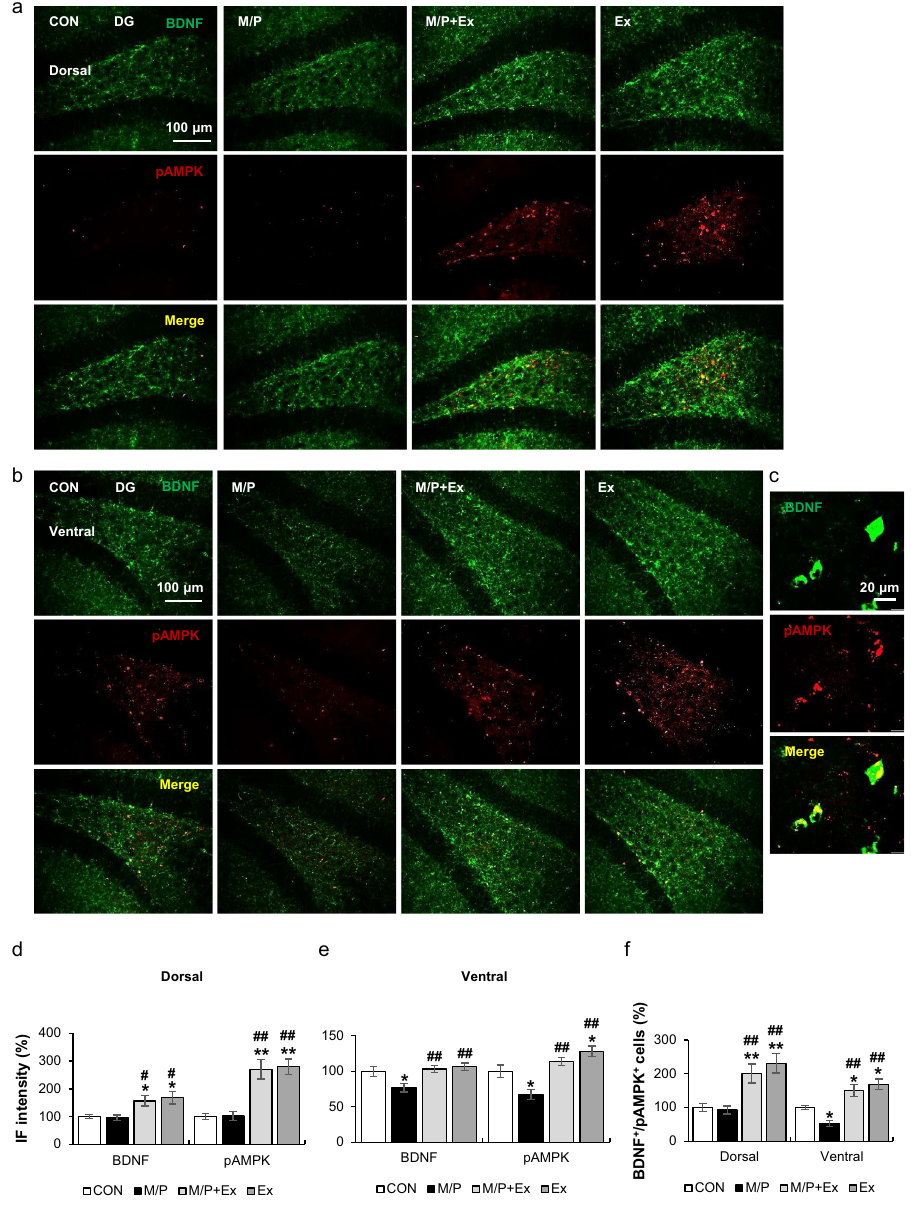
Figure 5. Rotarod walking exercise activated the AMPK/BDNF pathway in the SGZ area of M/P-treated mice. ( a ) Photomicrographs of the double fluorescent staining of dorsal SGZ BDNF + and pAMPK + cells (N = 8 in each group, 200 × of magnification). ( b ) Photomicrographs of the double fluorescent staining of ventral SGZ BDNF + and pAMPK + cells (N = 8 in each group, 40 × of magnification). ( c ) Representative photomicrograph of the high magnitude of SGZ BDNF + and pAMPK + cells (400 × of magnification). ( d , e ) Quantification of the fluorescent intensity of SGZ BDNF + and pAMPK + particles showing that exercise restored the M/P-induced decrease in BDNF + and pAMPK + cells in the ventral SGZ, and increased the number of BDNF + and pAMPK + cells in the dorsal region, regardless of MPTP treatment. ( f ) Quantification of the fluorescent staining of SGZ BDNF + / pAMPK + cells, showing that exercise restored the M/P-induced decrease in BDNF + /pAMPK + cells in the ventral SGZ, and increased the number of BDNF + /pAMPK cells in the dorsal region, regardless of MPTP treatment. Data are presented as mean ± SEM. *p < 0.05, vs. CON; **p < 0.01, vs. CON; # p < 0.05, vs. M/P; ## p < 0.01, vs.